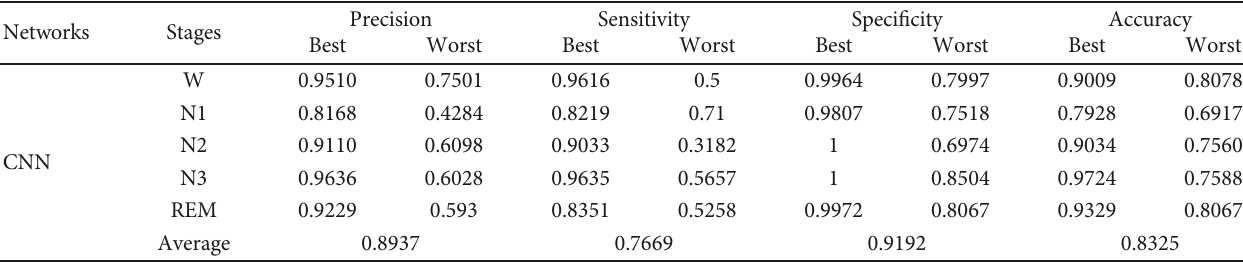
Table 3: Evaluation results of the original CNN with 5 channels.